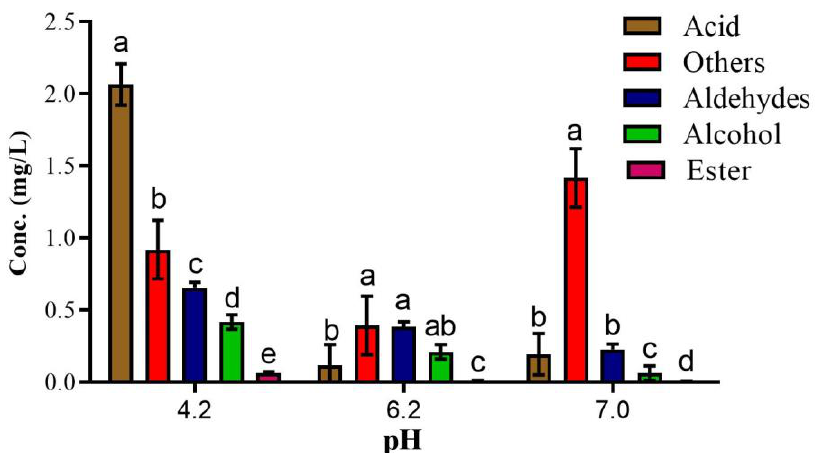
Figure 1. The concentration of identified UFAO-derived compounds in model reactions at different pH. Mean ± standard error ( n = 3); Different lettering indicates a significance level p < 0.005. Fatty acid oxidation reactions were carried out in pyrophosphate buffer at pH 4.2, with each reaction mixture containing 0.3 mL of fatty acids being blended in a 20 mL reaction tube using an electric blender. The following are the seven reaction mixtures: (1)